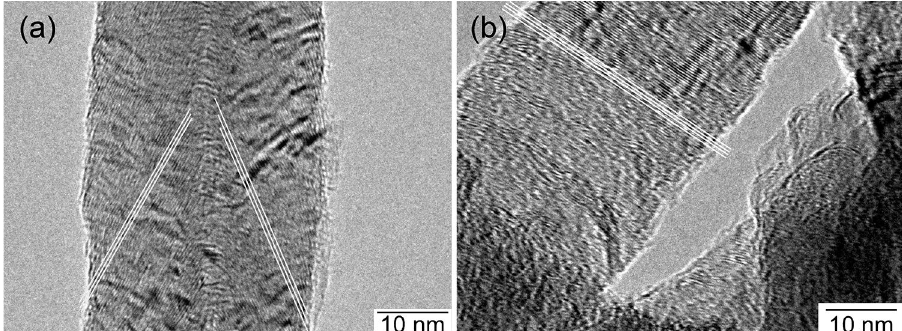
: BET surface area, V S BET pore volume